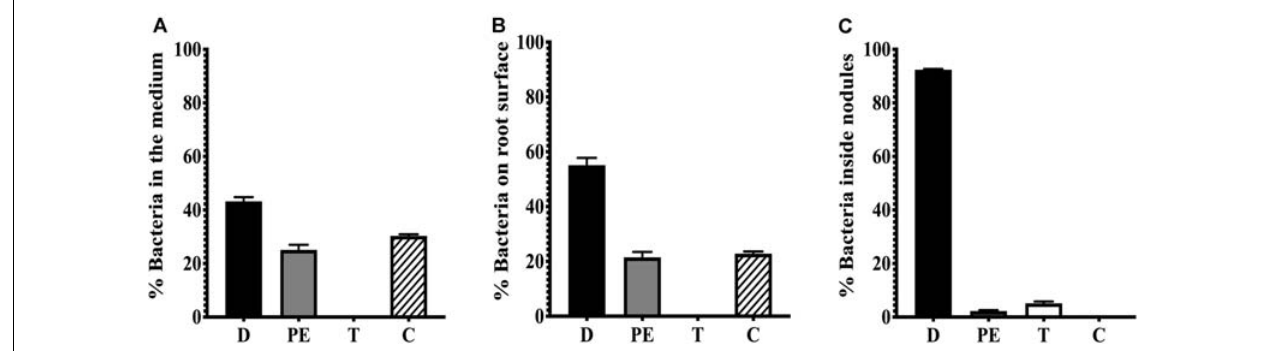
FIGURE 1 | Flow cytometry analysis of bacteria recovered from the root surface and nodules of plants infected with CFNX182-1. Plants were inoculated with strain CFNX182-1, which carries a RFP marker on the chromosome and a GFP marker on the pSym. Bacteria were recovered at 20 dpi from: (A) the medium, (B) the root surface and (C) nodules. Populations corresponding to donors (D) show red plus green fluorescence, putative endophytic recipients (PE) have no fluorescence, transconjugants of endophytic recipients (T) carry GFP and show green fluorescence, and pSym-cured derivatives (C) with RFP show red